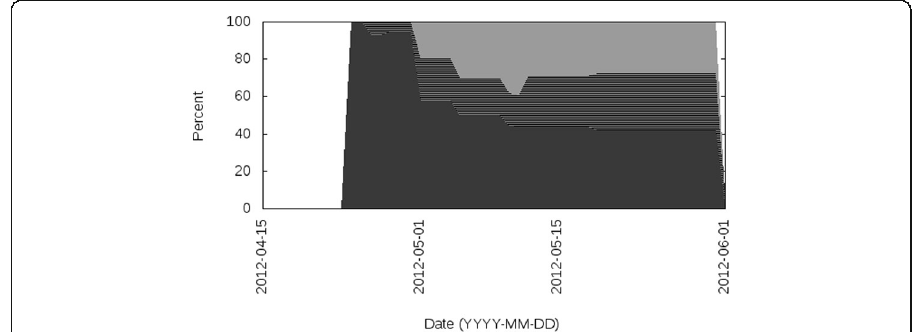
Fig. 6 Work distribution chart of students of Project4 obtained via